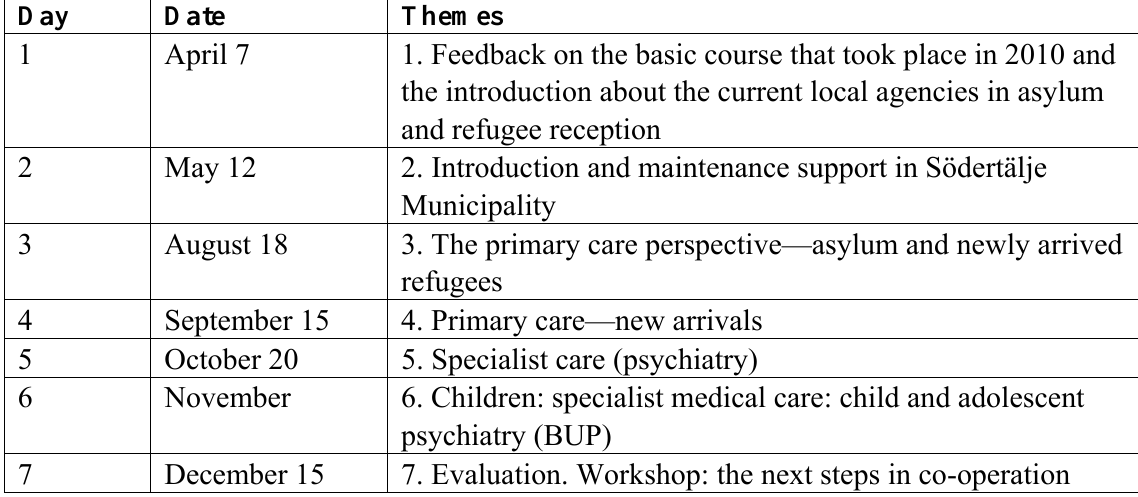
Table 1. The course covered seven themes on seven occasions in